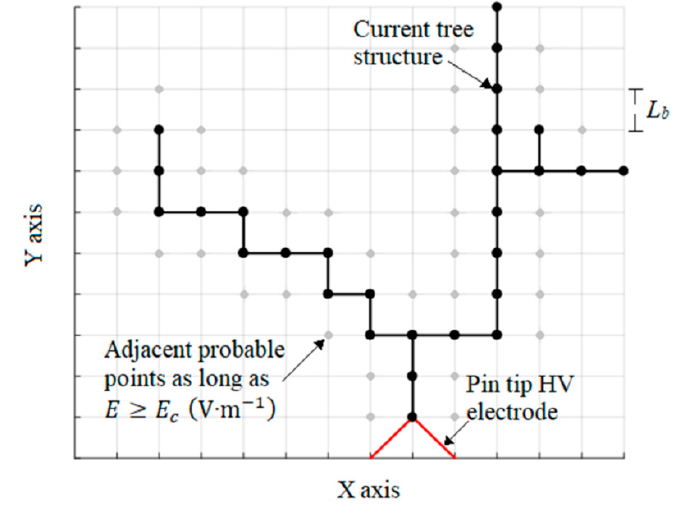
Figure 1. Tree structure propagation in a squared lattice of length L b (m).